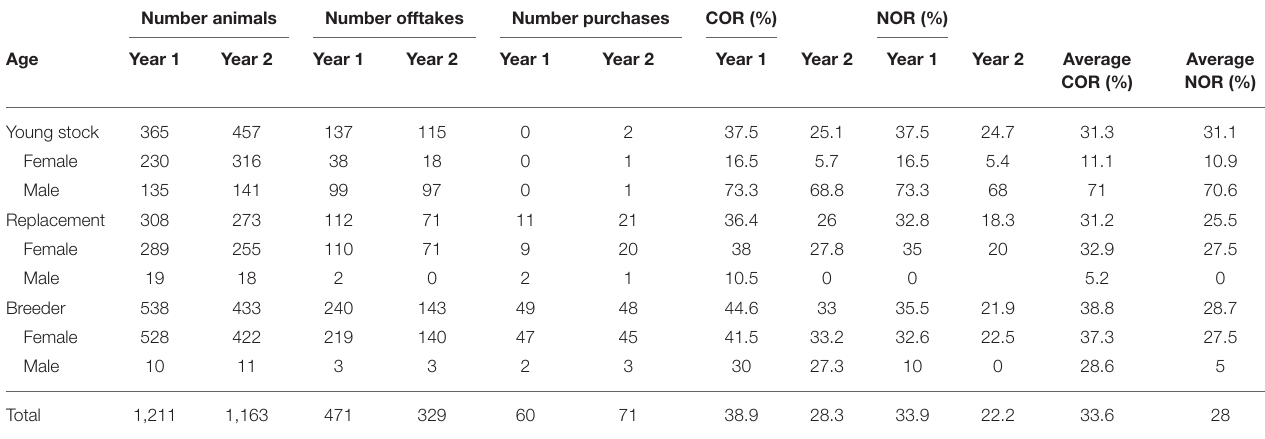
TABLE 3 | Crude offtake rates (COR) and Net offtake rates (NOR) by age and gender for the first and second year of the study. Number